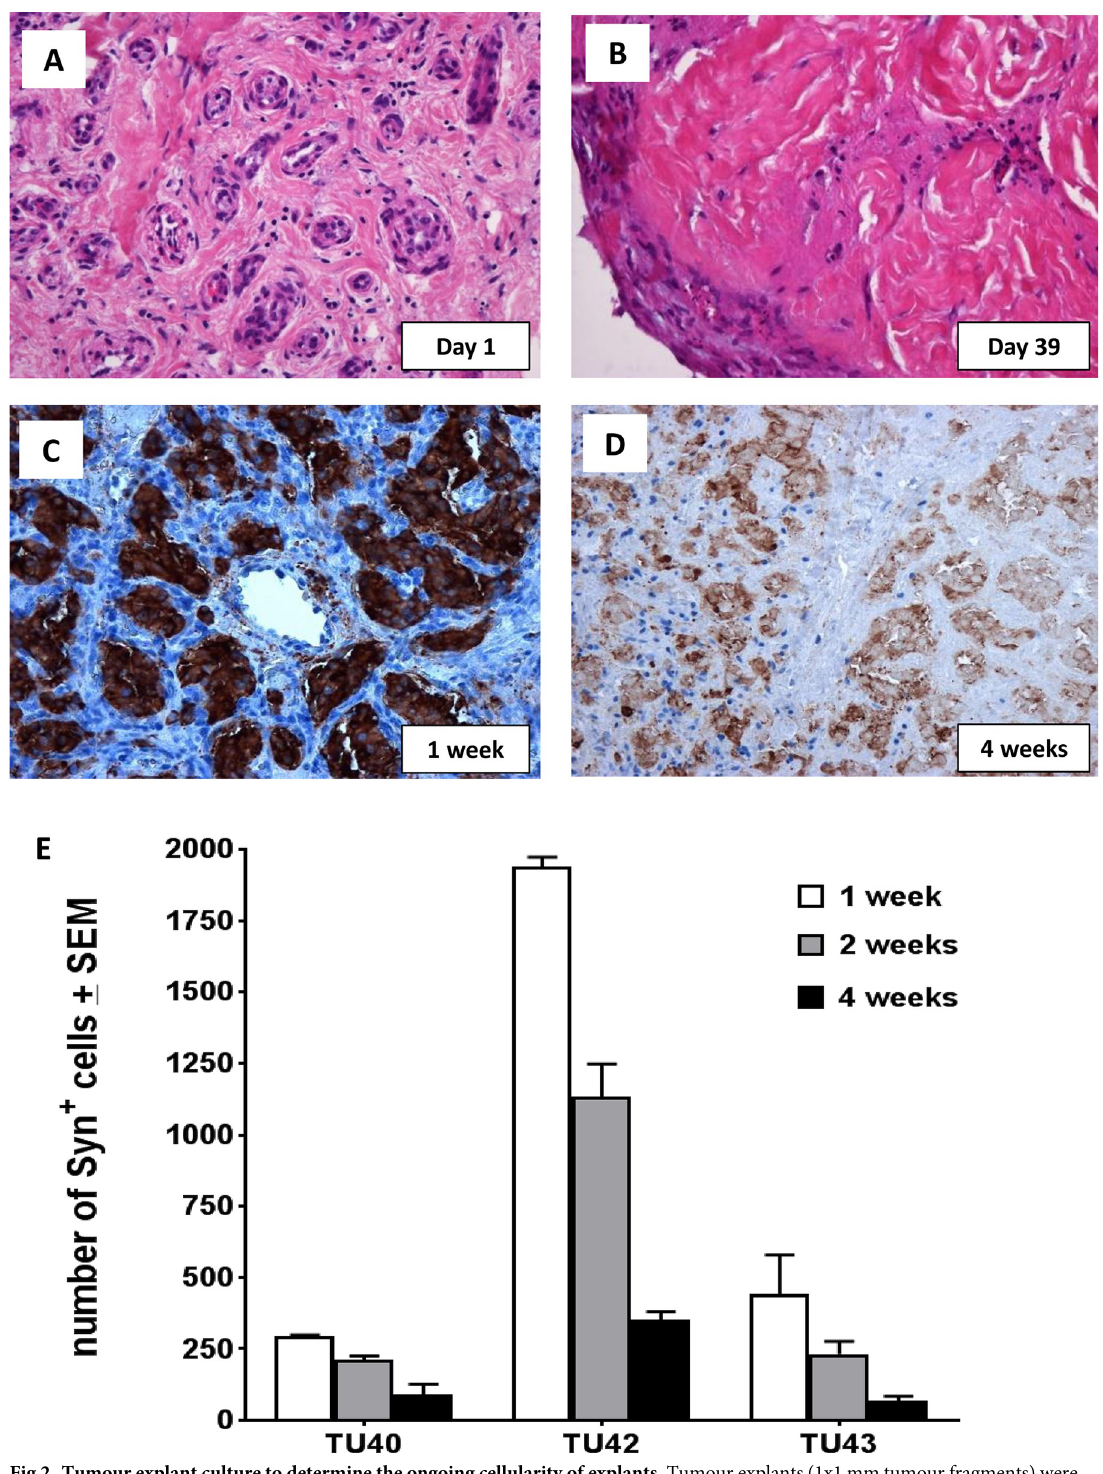
Fig 2. Tumour explant culture to determine the ongoing cellularity of explants. Tumour explants (1x1 mm tumour fragments) were cultured for up to 39 days to assess cellularity and remaining chromaffin tumour cells. At day 1, H&E staining of tumour 9 reveals the classic cell nest morphology in a highly stromal background (A, Tu9_CBT_SDHD_H&E_10x obj.). By around day 11 tumour fragments began to show clear signs of declining cellularity and an increase in eosin-avid (pink) acellular proteinaceous material (S2 Fig). By day 39, few cells of chromaffin appearance remained in the tumour fragments (B, Tu9_CBT_SDHD_H&E_10x obj.). Chromaffin cellularity was